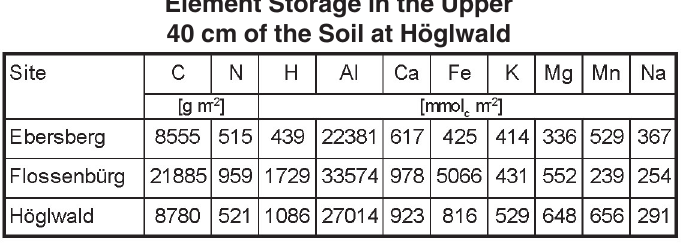
Element Storage in the Upper 40 cm of the Soil at Höglwald